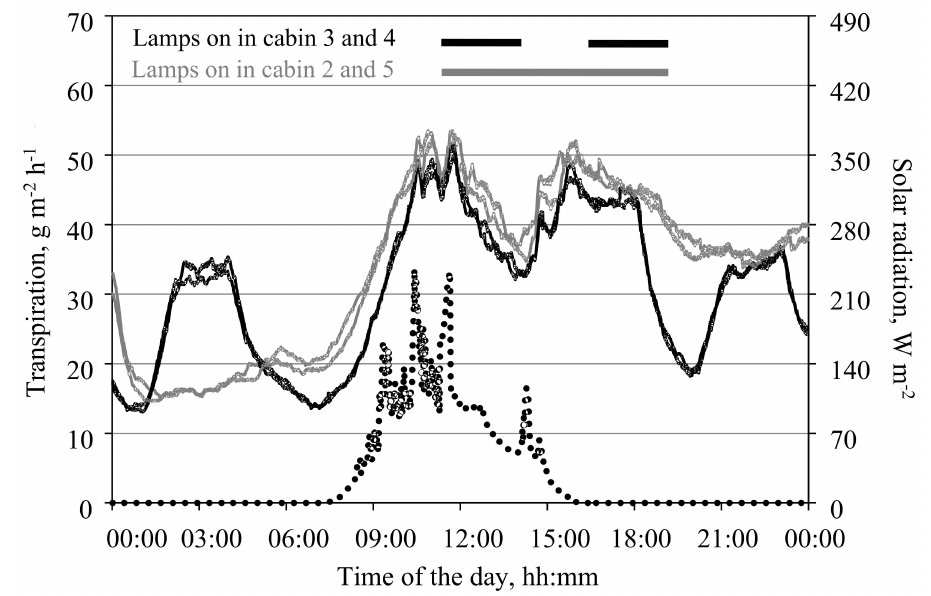
Figure 11. Daily course of transpiration of a tomato crop measured in the open chamber mode and global solar radiation on the top of the crop on 24 November 2015 under two di ff erent light regimens. Data shows measurements taken in 9-min intervals. Leaf area index was 1.4 m 2 m − 2 . H 2 O concentration in the cabin air ranged between 8 mmol mol − 1 during the dark and 14 mmol mol − 1 during the light phase. In two cabins, lamps emitted radiation of 78 W m − 2 from 15:00 to 24:00 while plants in two other cabins received radiation of the same intensity from 15:00 to 18:00, 20:00 to 23:00, and 01:00 to